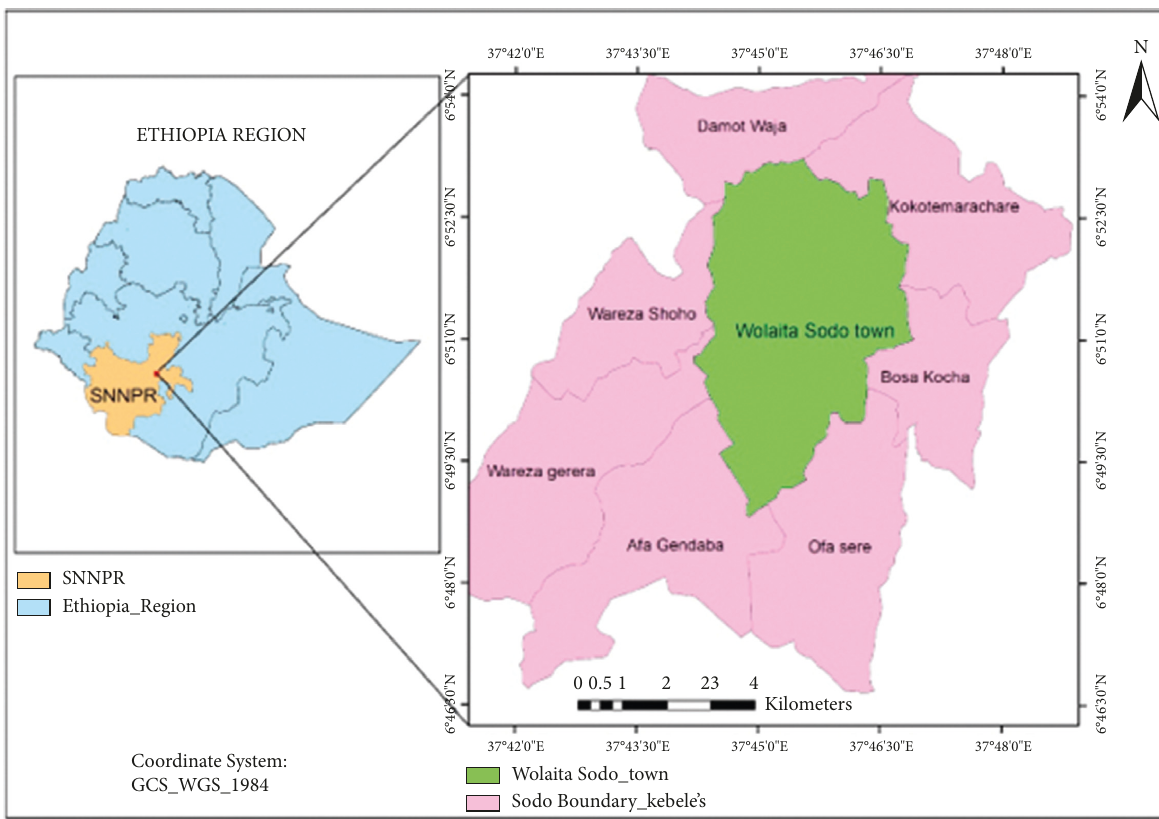
Figure 1: Map of the study